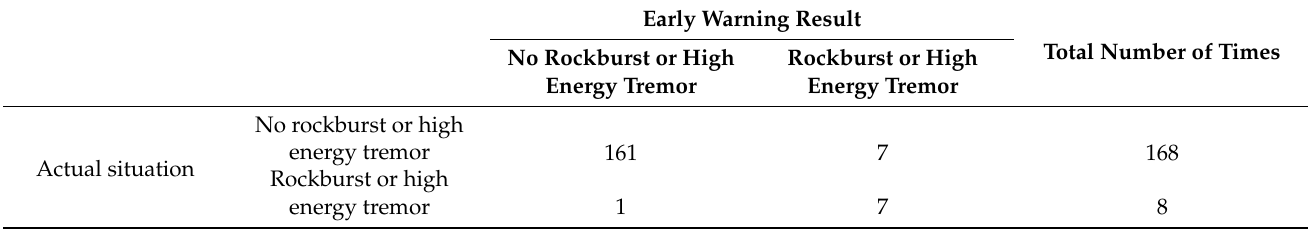
Table 4. Early warning effectiveness test results of “critical value + trend” early warning method.